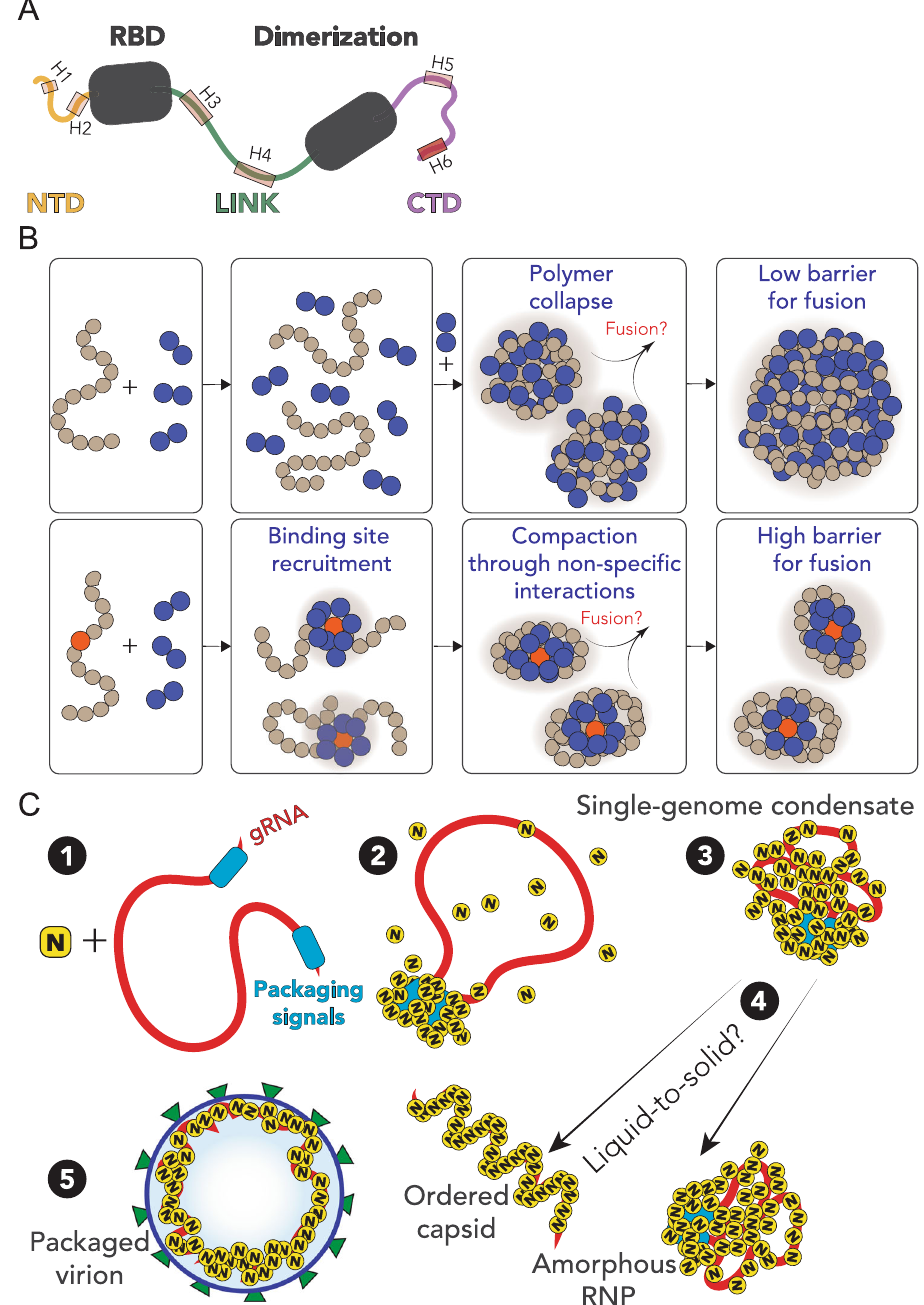
Fig. 7 Summary and proposed model. A Summary of results from single-molecule spectroscopy experiments and all-atom simulations. All three predicted IDRs are disordered, highly fl exible, and house a number of putative helical-binding regions which overlap with subregions identi fi ed previously to drive N protein function. B Overview of general symmetry-breaking model. For homopolymers, local collapse leads to single-polymer condensates with a small barrier to fusion, rapidly assembling into large multi-polymer condensates. When one (or a small number of) high-af fi nity sites are present, local clustering of binders at a lower concentration organize the polymer such that single-polymer condensates are kinetically stable. C Proposed model for SARS-CoV-2 genome packaging. (1) Simpli fi ed model of SARS-CoV-2 genome with a pair of packaging region at the 5 ′ and 3 ′ end of the genome. (2) N protein preferentially binds to packaging signal regions in the genome, leading to a local cluster of N protein at the packaging signal RNA. (3) The high local concentration of N protein drives condensation of distal regions of the genome, forming a stable single-genome condensate. (4) Single-genome condensates may undergo subsequent maturation through a liquid-to-solid (crystallization) transition to form an ordered crystalline capsid, or solidify into an amorphous ribonuclear particle (RNP), or some combination of the two. While in some viruses an ordered capsid clearly forms, we favor a model in which the SARS-CoV-2 capsid is an amorphous RNP. Compact single-genome condensates ultimately interact with E, S, and M proteins at the membrane, whose concerted action leads to envelope formation around the viral RNA and fi nal virion packaging.